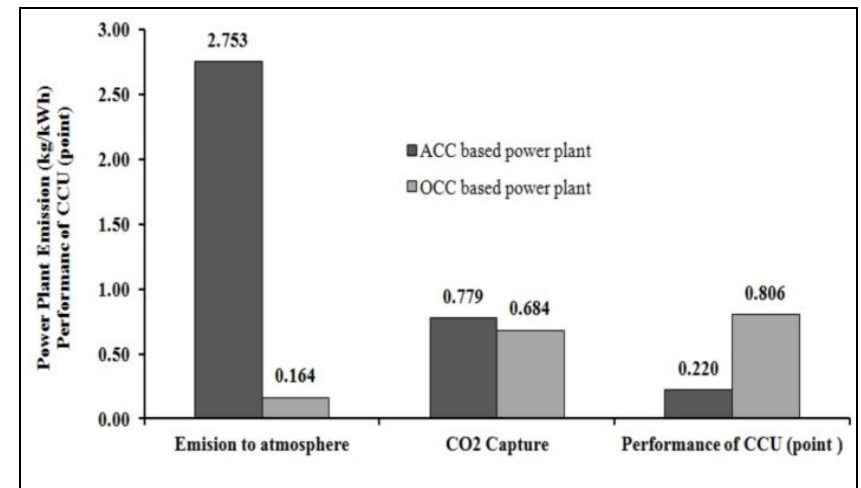
Figure 3. Environmental impact of the plants